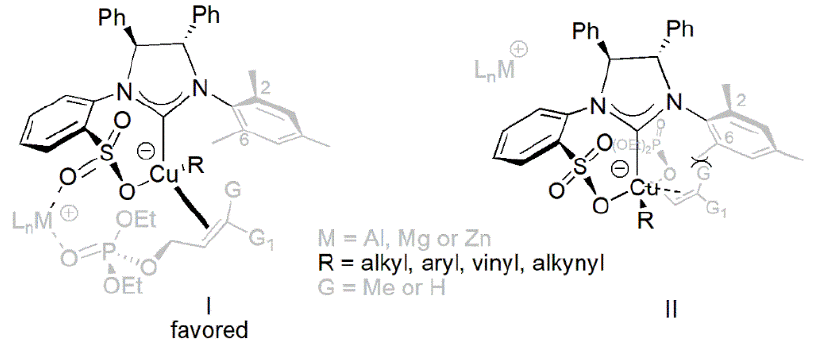
Molecules 2022 , 27 , x FOR PEER REVIEW 27 of 73